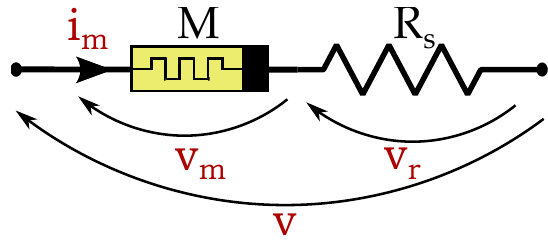
Figure 1. Measurement